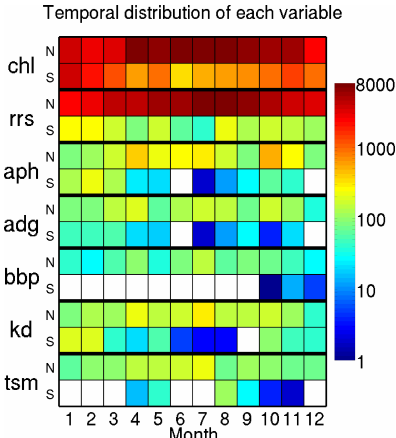
Figure 3. Temporal distribution of chlorophyll a concentration (chl), remote-sensing reflectance (rrs), algal pigment absorption co- efficient (aph), detrital plus CDOM absorption coefficient (adg), particle backscattering coefficient (bbp), the diffuse attenuation co- efficient for downward irradiance (kd) and total suspended matter (tsm) in the final table. All chlorophyll data were considered, but for a given station, HPLC data were selected if available. Colours indi- cate the number of stations available for each variable, as a function of month and hemisphere of data acquisition (N – Northern Hemi- sphere; S – Southern Hemisphere). The empty (white) squares indi- cate no data for that